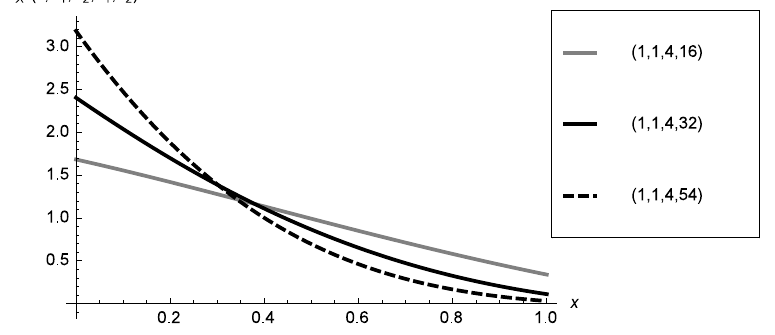
Figure 10 { Plots of the density of X ′′ (cid:24) CDNCB ( (cid:11) 1 ; (cid:11) 2 ; (cid:21) 1 ; (cid:21) 2 ) for (cid:11) 1 = (cid:11) 2 = 1 and selected values of (cid:21) 1 ; (cid:21) 2 .